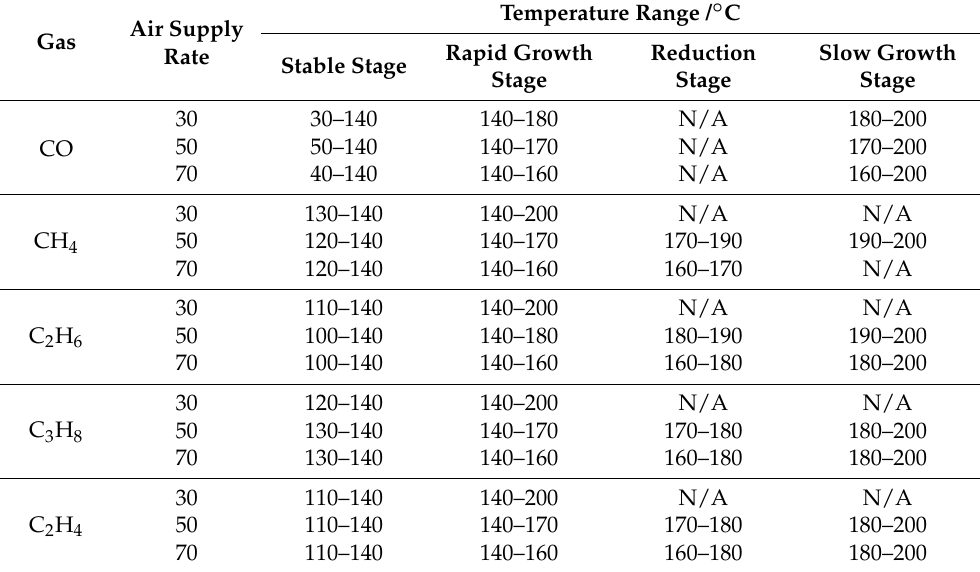
Table 1. Oil shale low-temperature oxidation and gas production